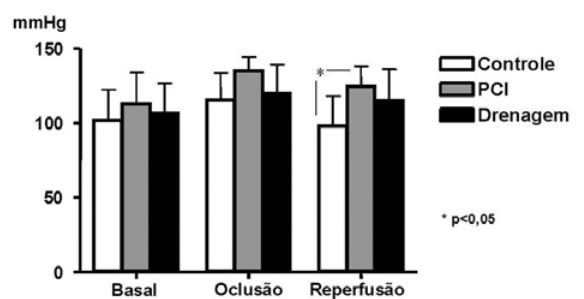
Fig. 1 - Pressão arterial sistêmica média proximal, antes, durante e após a oclusão da aorta, nos três grupos. Os valores estão expressos em média e desvio-padrão